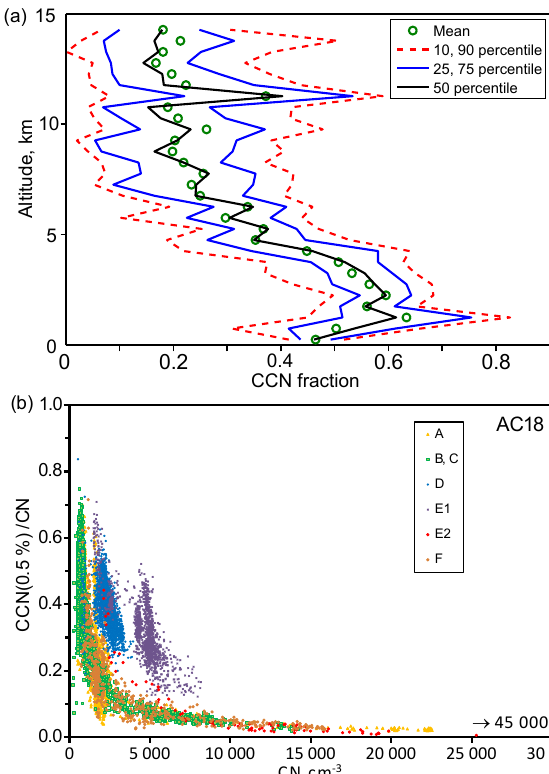
Figure 12. (a) CCN fraction ( N CCN0 . 5 /N CN ) vs. altitude (all data). The peak at 11km is caused by the inclusion of a large number of measurements from flight AC20 on a horizontal leg at 11km, which was influenced by biomass burning (see Sect. 3.6). (b) CCN fraction vs. CN concentration for specific segments from flight AC18 (see text for discussion).